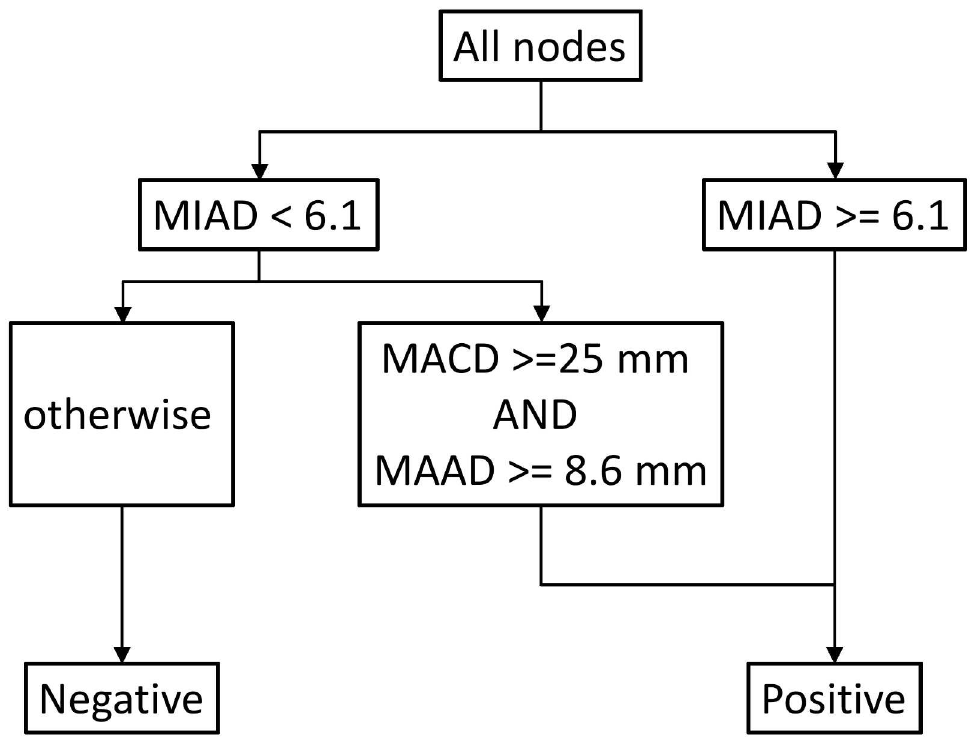
Fig 7. Stage I optimal approach. With the method of brute force attack, nodes were determinedto be positive accordingto an MIAD (cid:21) 6.1 mm. Note that the combination approach increased the accuracy by only 0.4% [from 89.1% (590/663) to 89.4% (593/663)] by correcting three false negative errors. MIAD, minimal axial diameter; MAAD, maximal axial diameter; MACD, maximal coronal diameter.